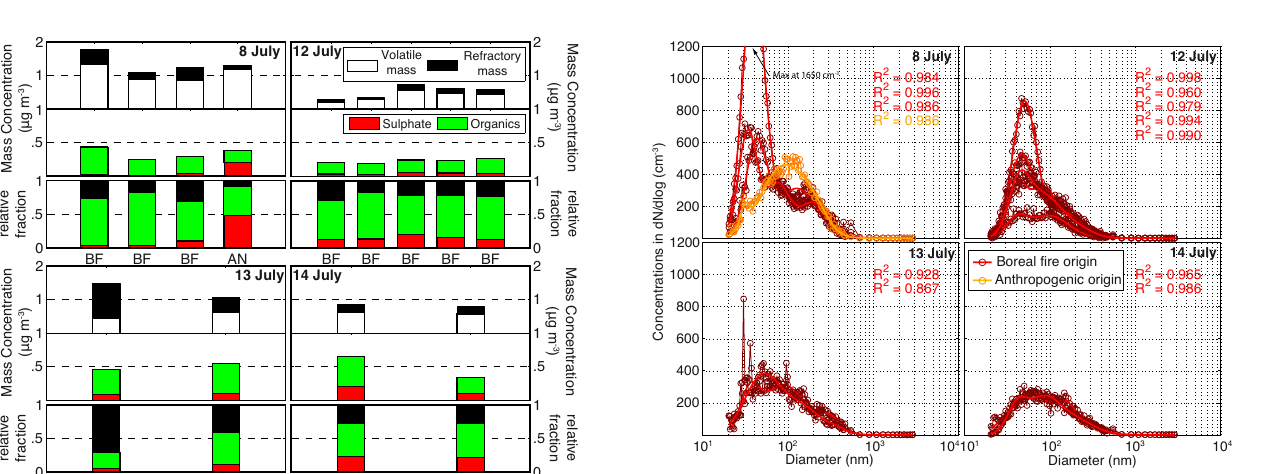
Fig. 6. Aerosol chemical composition for selected time windows. For each flight, the top panel presents the aerosol volatile and re- fractory volume fractions. Middle panels indicate the amount of organics and sulphate measured by the AMS, while the bottom pan- els compile top and middle panels in order to obtain the partitioning of refractory mass, organics and sulphate (Air mass origins deter- mined with FLEXPART integrated-column PES are noted with AN for North-American anthropogenic and BF for Canadian boreal for- est fires).